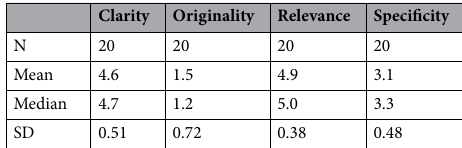
Table 2. Mean and median grades for all topics across all